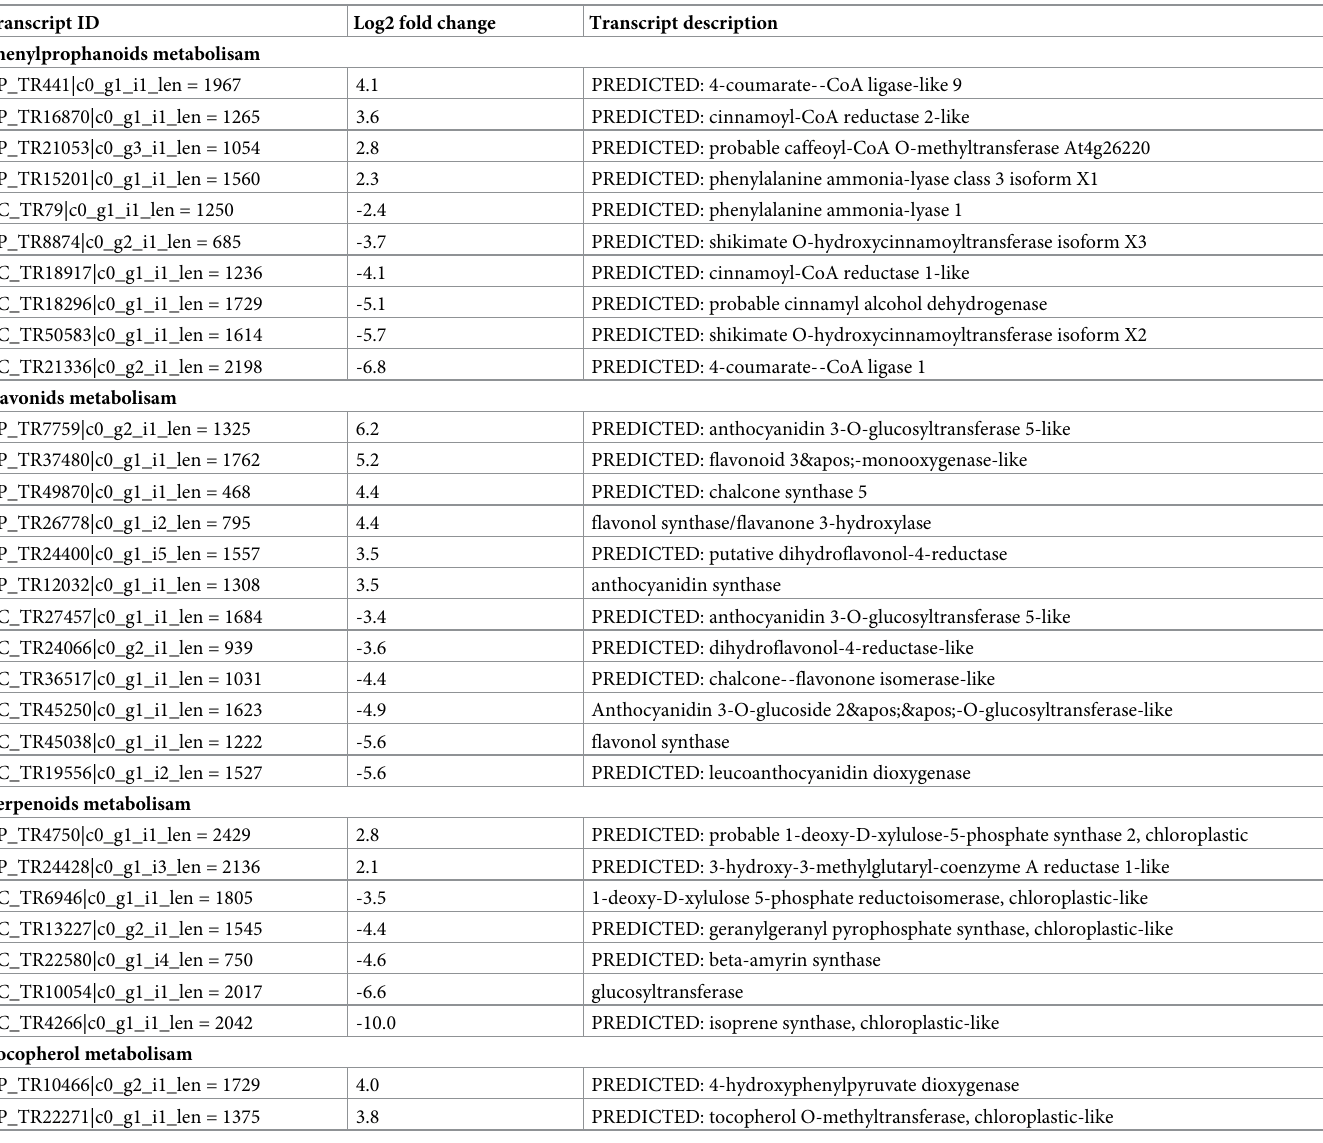
Table 3. Representative transcripts related to secondary metabolite synthesis pathways differentially expressed in C . platycarpus compared to C . cajan